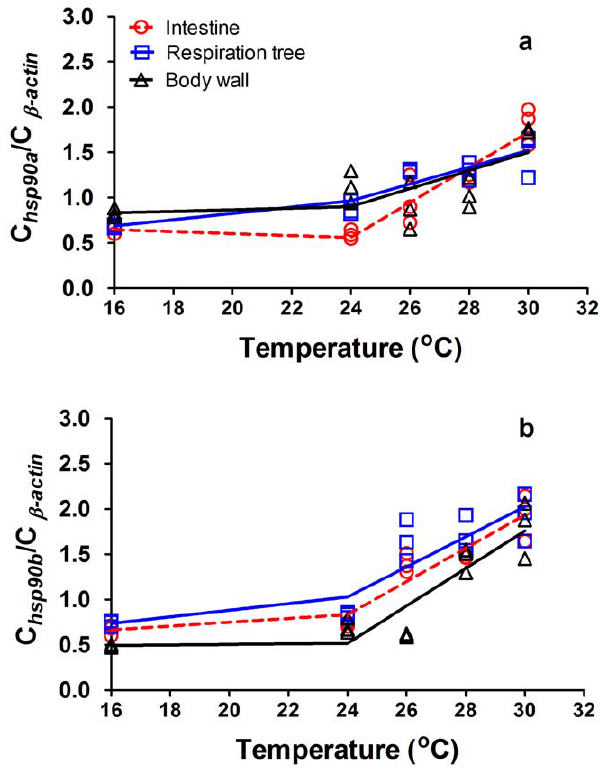
Figure 3. The two-stage segmental regressions of the peak values of (a) hsp90a and (b) hsp90b and temperature of sea cucumber Apostichopusjaponicus in intestine, respiratory trees and body wall.